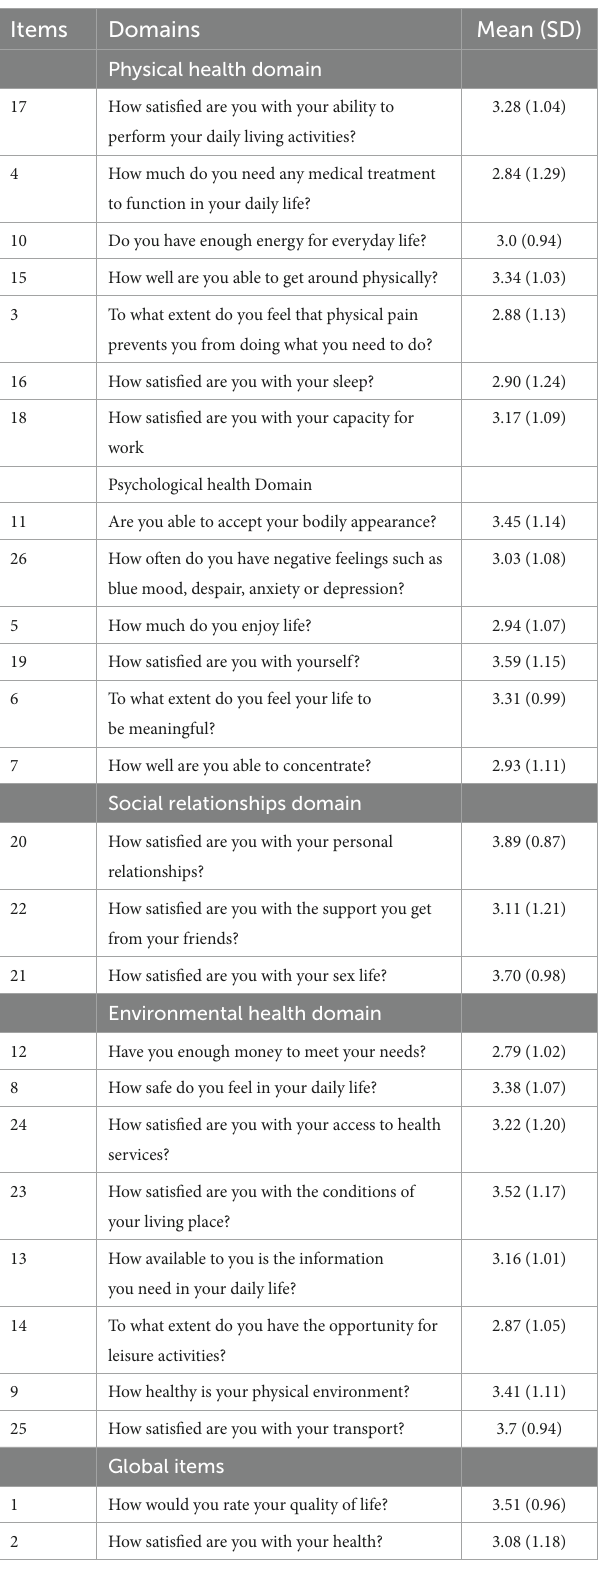
TABLE 1 Descriptive statistics of the individual items in the WHOQOL- BREF questionnaire.